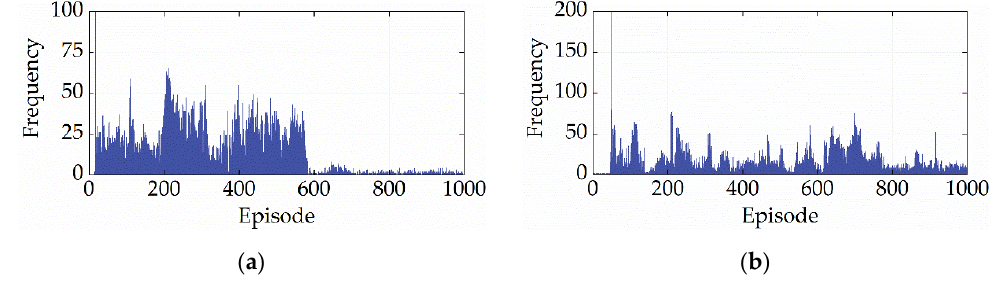
( b ) Figure 12. Reward curve under different driving cycles. ( a ) CHTC-B; ( b ) WVUCITY. ( a ) ( b ) Figure 13. Terminal SOC curves under different driving cycles. ( a ) CHTC-B; ( b ) WVUCITY. Figure 14 shows the number of invalid actions output by SD3-AM in each round dur- ing the learning process. From Figure 14, SD3-AM has difficulty avoiding outputting in- valid actions. The first reason is that SD3-AM avoids falling into the local optimum by randomly exploring the entire action space, which puts the SD3 algorithm at risk of se-